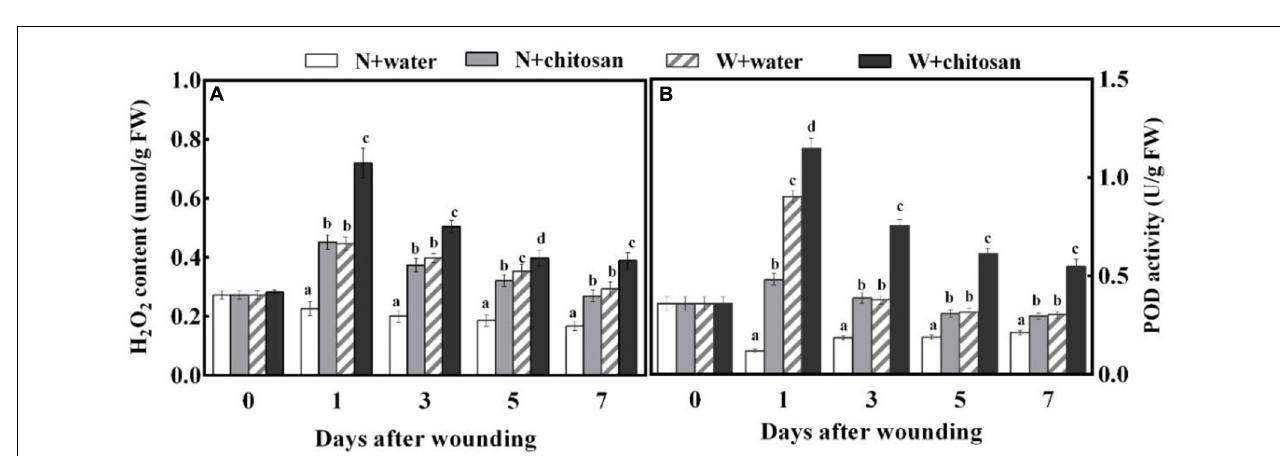
FIGURE 1 | Effect of chitosan treatment on weight loss (A) and disease index of inoculated fruit with P. expansum (B) . Non-wounded and treated with sterile water (N + water), non-wounded and treated with chitosan (N + chitosan), wounded and treated with sterile water (W + water), and wounded and treated with chitosan (W + chitosan). Vertical bars indicate standard error of means. Alphabets indicate significant differences ( p < 0.05).